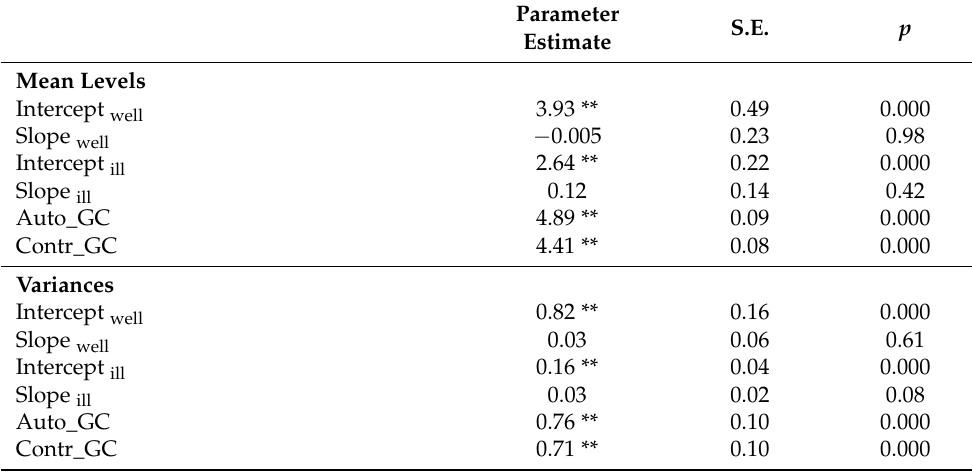
Table 8. Parameter Estimates for LGM Models: GCO and